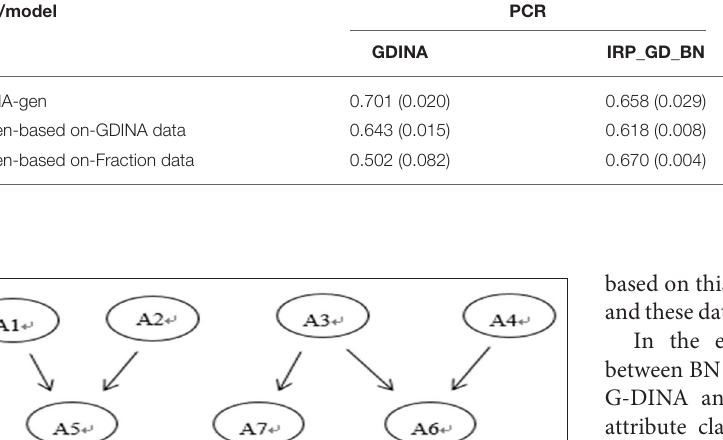
TABLE 8 | The PCR and AACR by BNs and G-DINA from the data generated by G-DINA and the data generated by BNs based on the G-DINA data and Fraction data. DATA/model